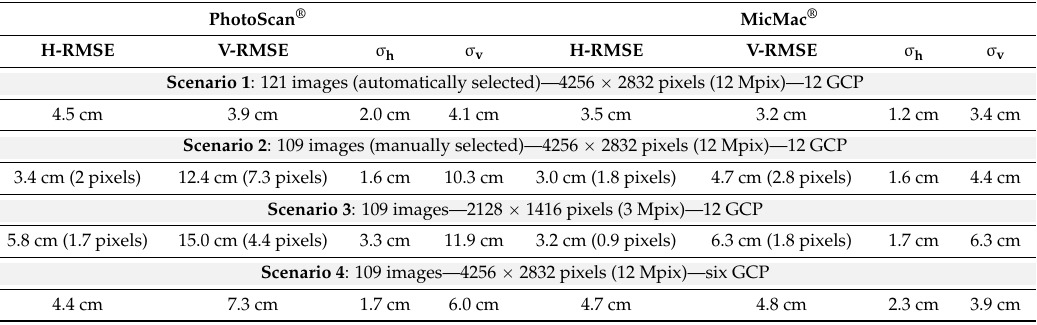
Table 2. Accuracy of the orthophoto and DSM computed by PhotoScan and Micmac. The accuracy is calculated with nine ground truth reference points. H-RMSE/V-RMSE are respectively Horizontal/Vertical Root Mean Square